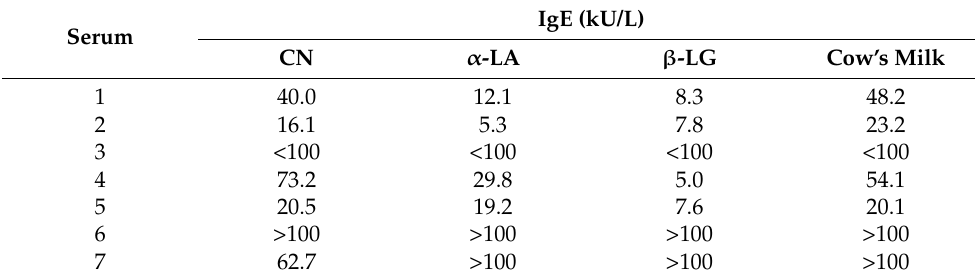
Table 1. Sera used in the study. Specific IgE levels (kU/L) towards casein (CN), α -lactalbumin ( α -LA), β -lactoglobulin ( β -LG) and cow’s milk of the human sera used in the inhibition ELISA and mast cell activation